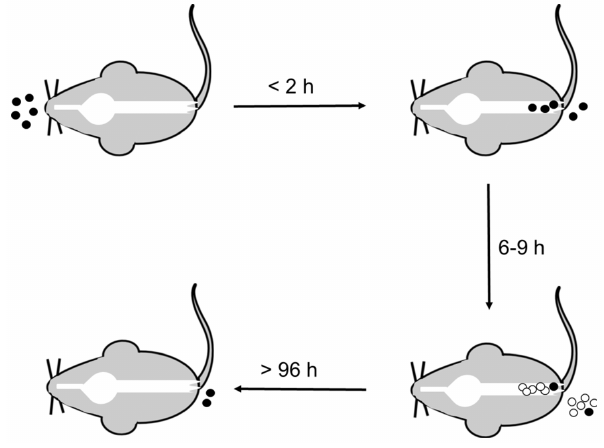
Figure 7. Time line model for CDI onset in mice. C. difficile spores (black circles) are ingested by the host. Spores rapidly transit through the upper GI tract and colonize the colon and cecum. Spore shedding begins less than 2 hours post-ingestion. Between 6 and 9 hours after ingestion sufficient numbers of spores germinate to establish infection. The outgrowing C. difficile cells (white circles) proliferate in the lower intestine, are shed, and can re-sporulate. A small amount of ingested spores remain in the lower intestine for more than 96 hours post ingestion.